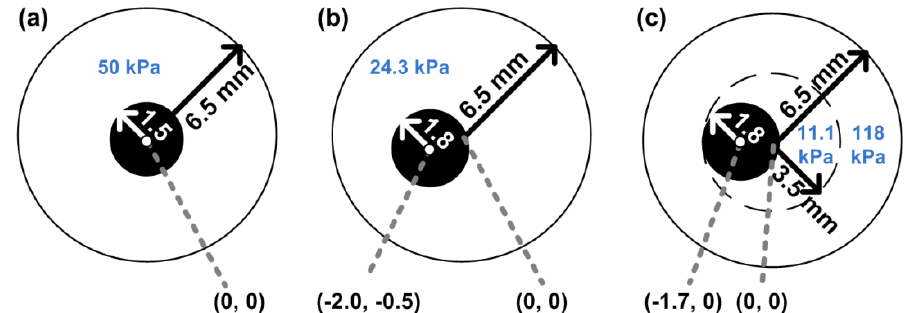
Figure 1. The geometries and Young’s moduli of the vessels investigated. ( a ) A concentric homogeneous vessel; ( b ) An eccentric homogeneous vessel; ( c ) An eccentric vessel consisting of two layers with different